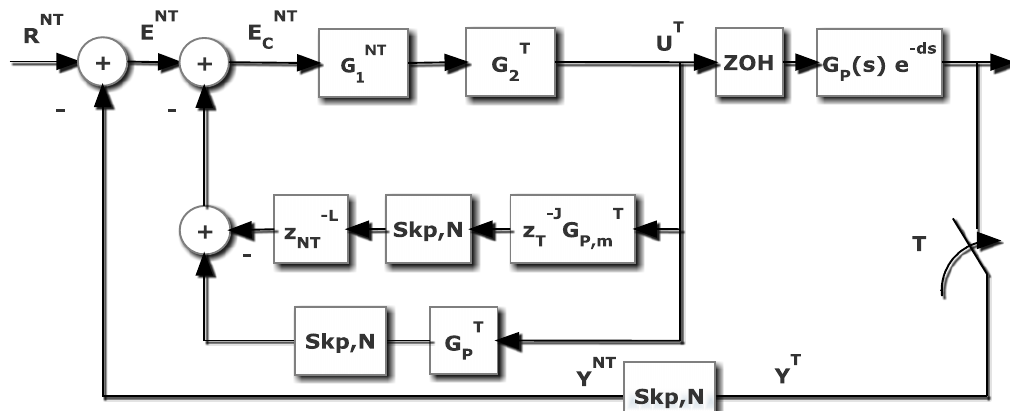
Figure 6. Dual rate scheme with Smith’s